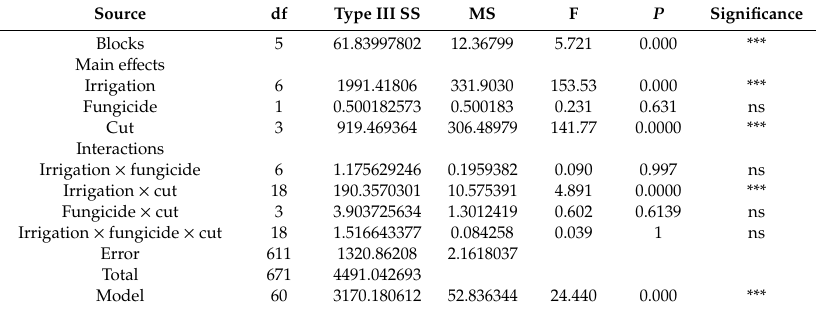
df = degree of freedom, SS = sum squares, MS = mean squares, F = the test statistic, P = p -value, Significance: ns = non-significant; *** = significant at p value = 0.001.